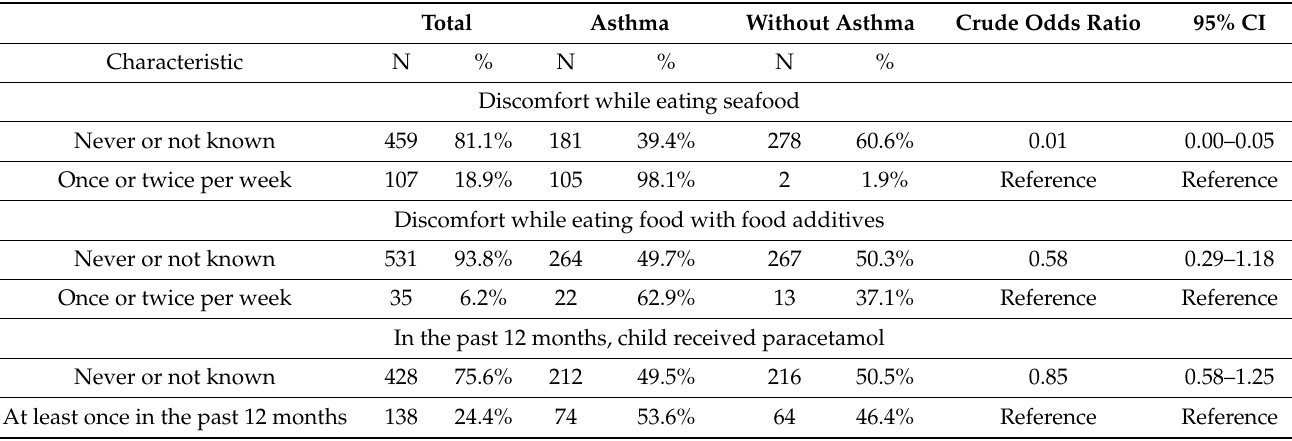
Table 6. Odds of reporting asthma with estimated exposure to select other environmental agents assessed in this